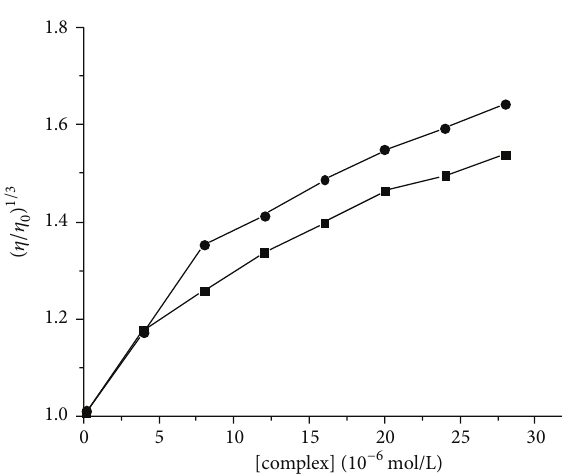
Figure 7: Effects of increasing concentrations of ligand L ( e ) and La (III) complex ( ◼ ) on the viscosity of CT-DNA, [DNA] = 100 𝜇 M, [compound] = 0, 4, 8, 12, 16, 20, 24, and 28 𝜇 M, respectively.